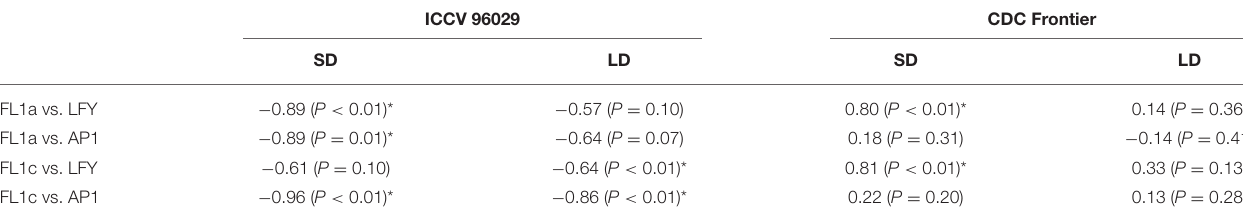
TABLE 1 | Correlations between the expression dynamics of TFL1a/TFL1c and LFY/AP1 in the data from (Ridge et al.,